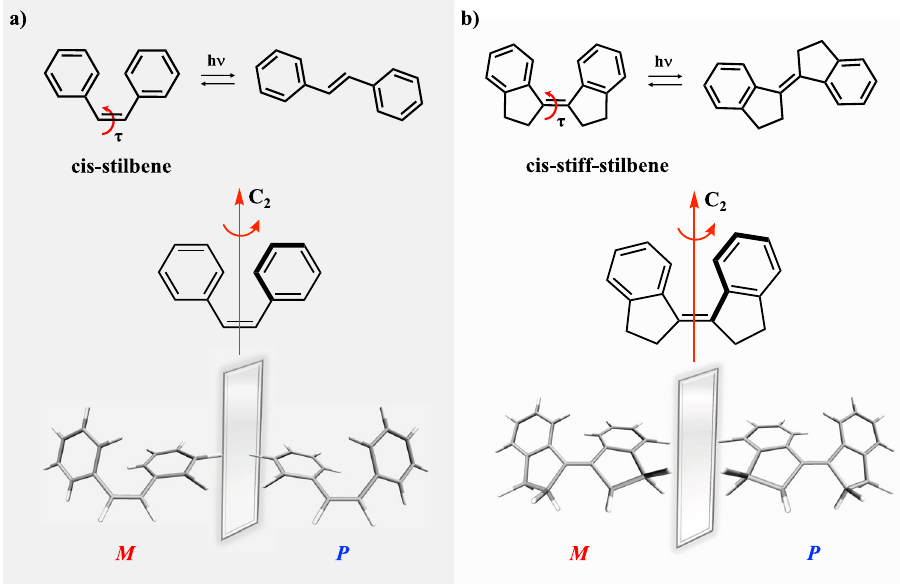
Fig. 2 Schematic photochemistry and depiction of P and M enantiomers. Cis -stilbene is shown on the left ( a ) and cis -stiff-stilbene is shown on the right ( b ). The C 2 rotational axis is highlighted in red along with the twist angle ( τ ) around the carbon – carbon double bond (de fi ned as the average of the two dihedral angles involving the central C = C double